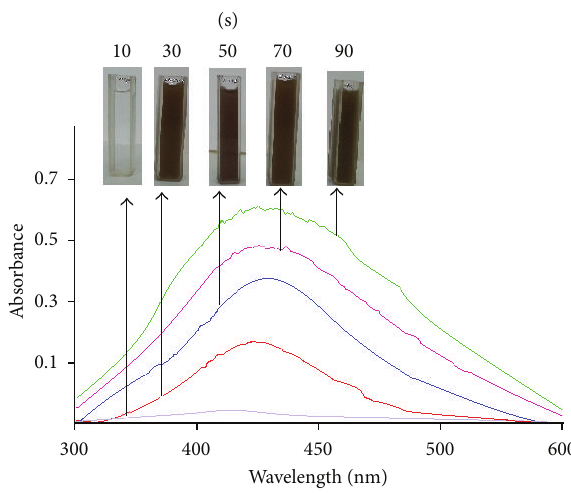
Figure 1: UV-visible spectrum showing the microwave irradiated silver nanoparticles synthesis recorded as a function of